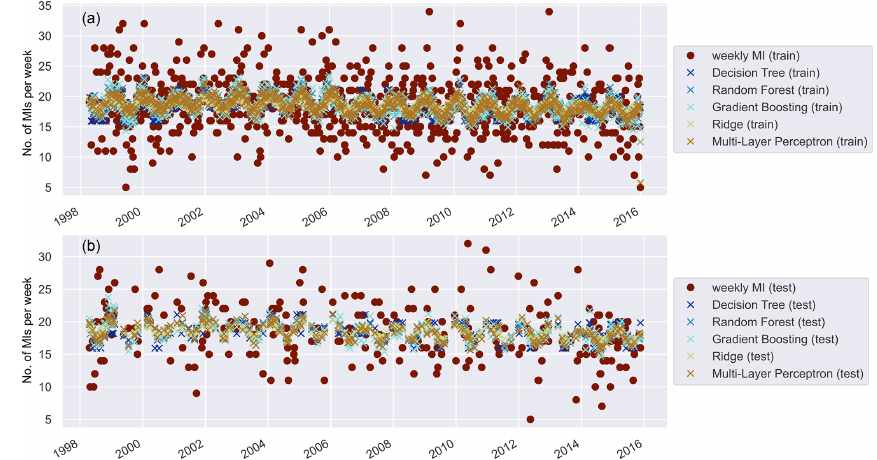
Figure 3. Daily predictions aggregated to 7d intervals for all models. Shows predicted (crossed) and observed MI (dotted) for the training (a) and test (b)